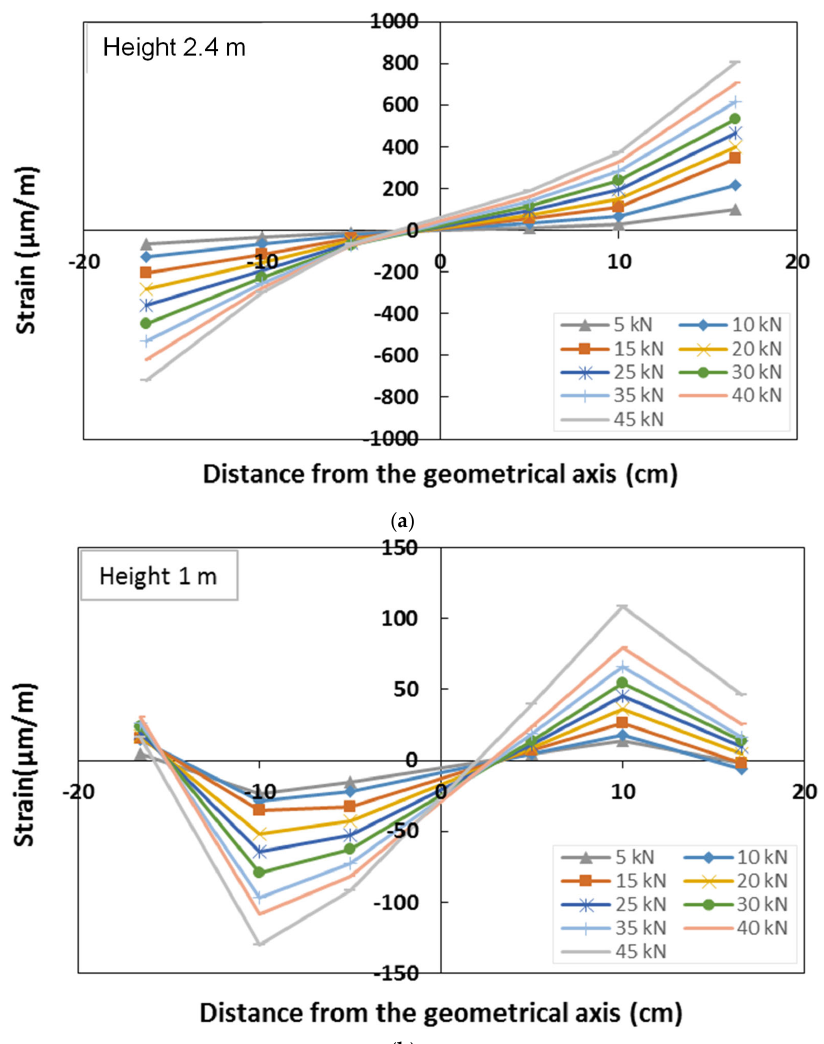
Figure 18. Strain distribution along the lateral web of the column: ( a ) section at a height of 2.4 m; ( b ) section at a height of 1.0 m.